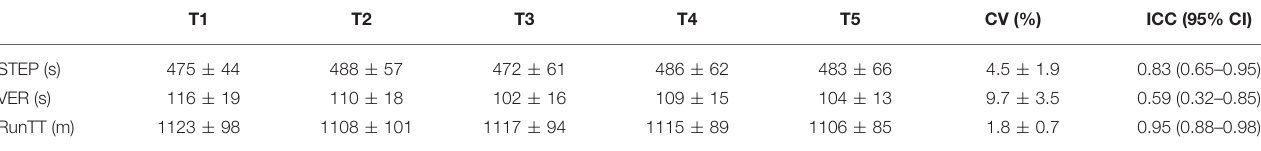
TABLE 3 | Mean ± SD of performance for each trial for the incremental test to volitional exhaustion (STEP), the verification phase (VER), and the four-minute running time-trial (RunTT) with associated coefficient of variation (CV) and intraclass correlation coefficient (ICC) data. T1 T2